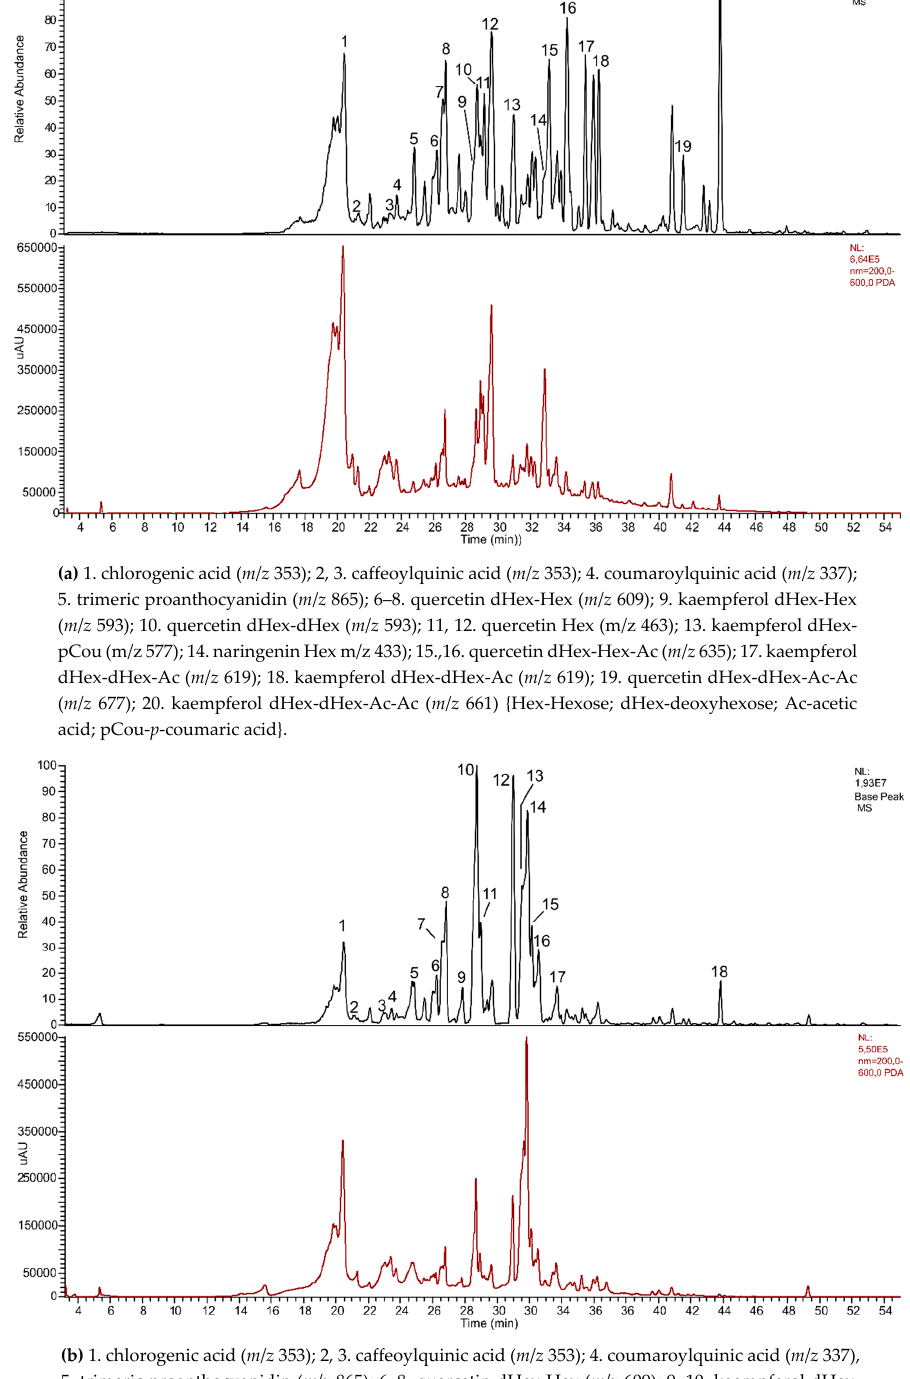
Table 4. Total polyphenols, phenolic acids, and flavonoids in ethanolic extracts from leaves of in vitro- propagated plantlets, field-grown plant, and fruits of Chaenomeles japonica . Content of Selected Groups of Compounds in Extracts [± SD]